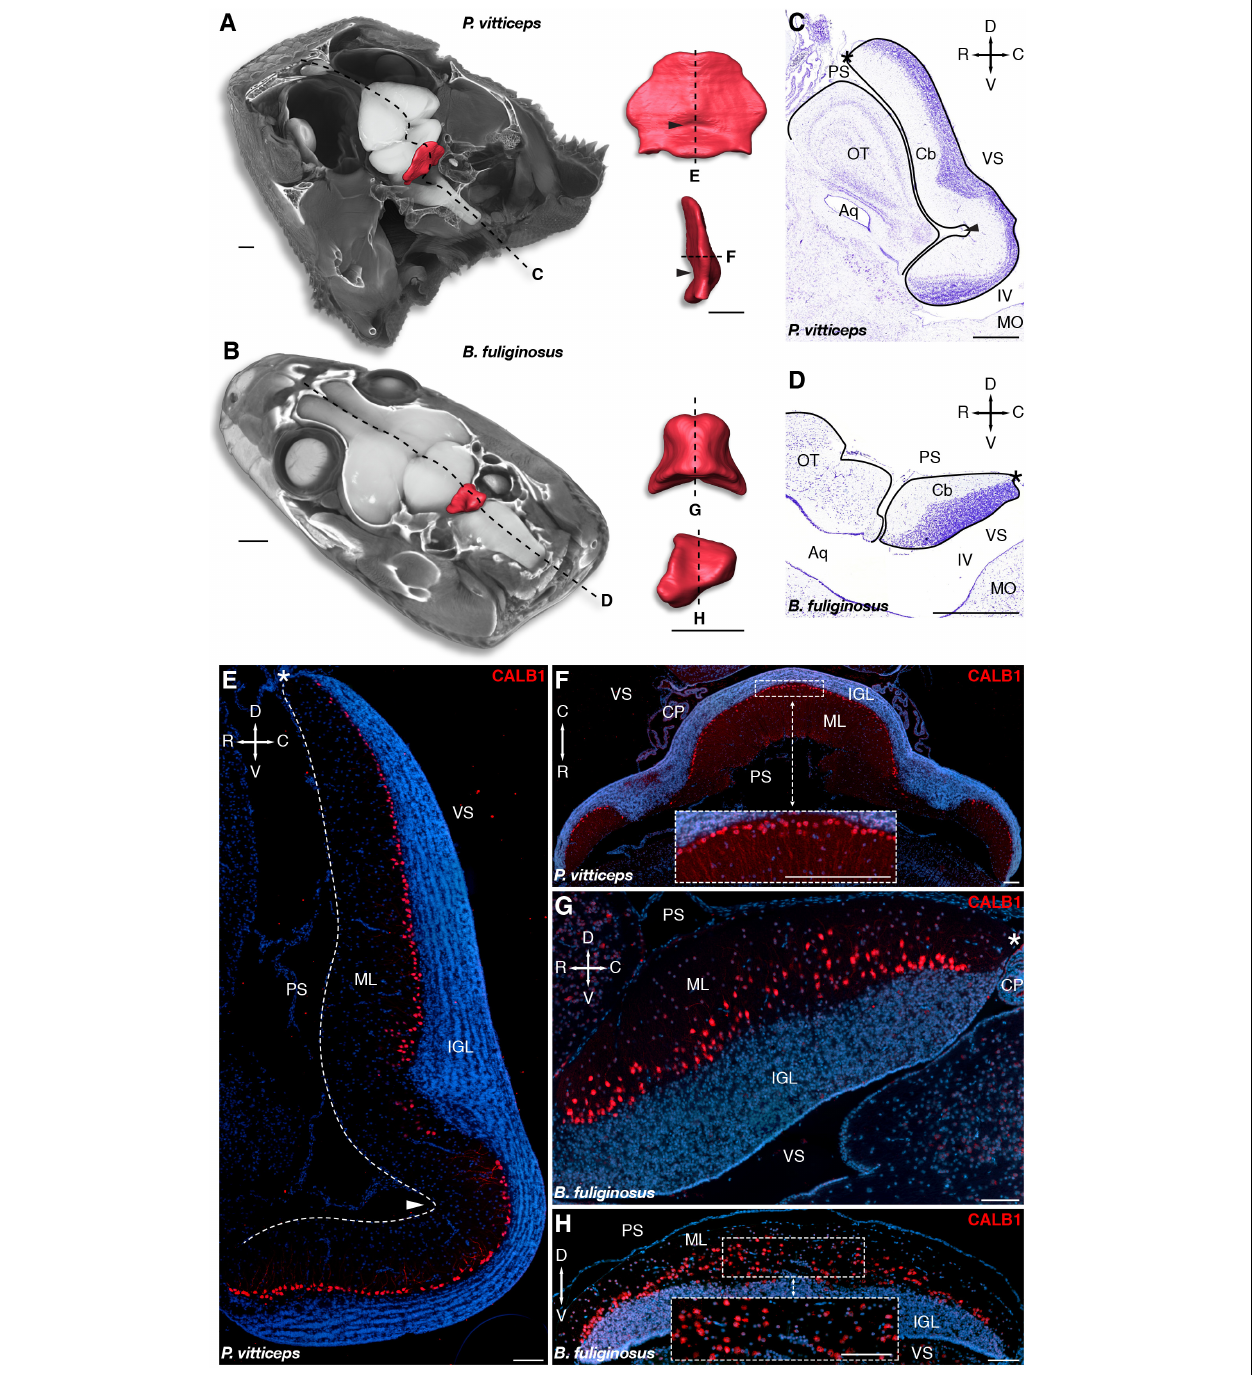
FIGURE 1 | Morphology and cellular arrangement of bearded dragon lizard ( P. vitticeps ) and African house snake ( B. fuliginosus ) cerebellum. (A,B) 3D-volume rendering and high-resolution whole-brain segmentation of iodine-stained juvenile heads of P. vitticeps (A) and B. fuliginosus (B) highlighting the cerebellum structure (red color). High magnifications of 3D-rendered cerebella of P. vitticeps (A) and B. fuliginosus (B) are shown in pial (top) and lateral (bottom) views in the right column. Arrowheads indicate the position of the incomplete fissure in P. vitticeps cerebellum. Dashed lines and letters mark the sectioning planes relative to the histological preparations and immunostaining experiments in panels (C,D) and (E–H) , respectively. (C,D) Nissl staining of the cerebellum and neighboring brain regions in P. vitticeps (C) and B. fuliginosus (D) . Black lines demarcate the contour of the cerebellum and adjacent brain regions. The arrowhead in panel (C) indicates the position of the incomplete fissure in P. vitticeps cerebellum, and asterisks in panels (C,D) indicate the position of the embryonic upper rhombic lip. Crossed arrows point toward rostral (R), caudal (C), dorsal (D), and ventral (V) directions. (E–H) Immunodetection of Purkinje cells (PCs) with CALB1 marker,